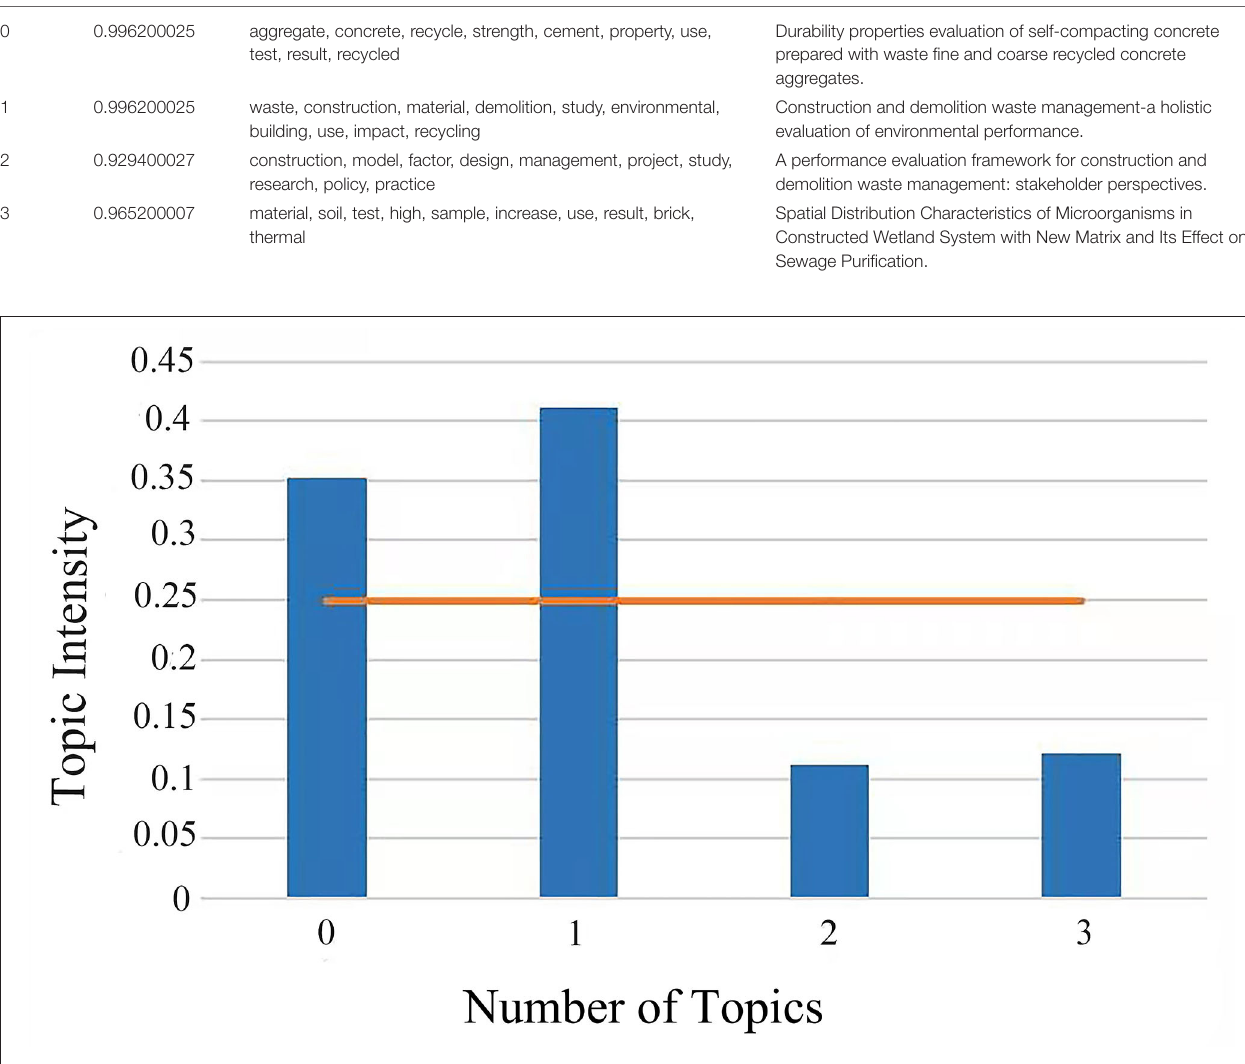
FIGURE 3 | Topic intensity